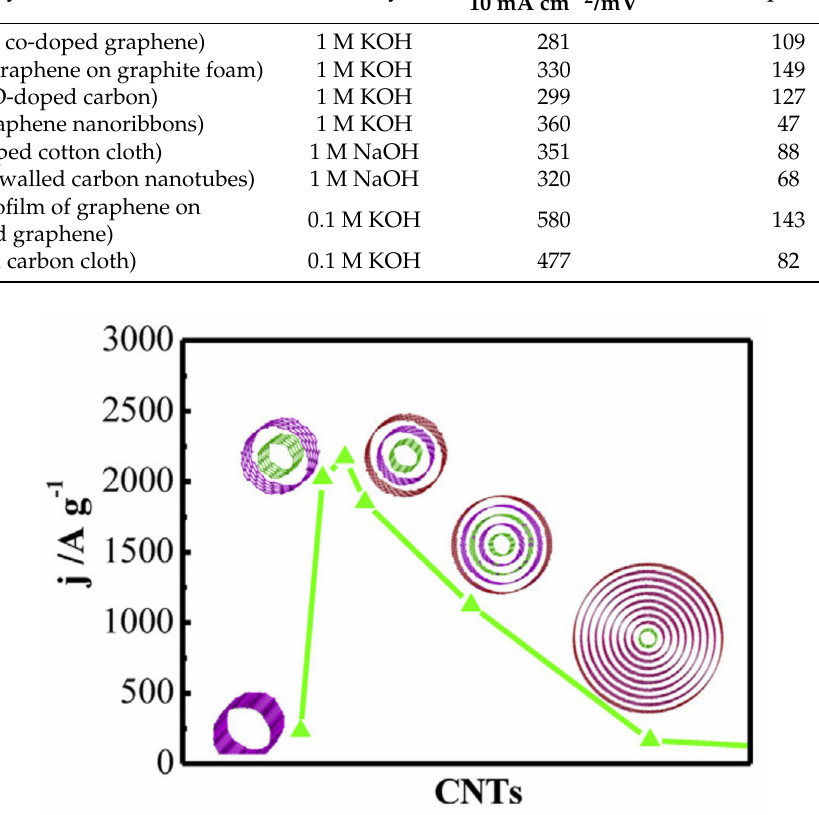
Figure 9. A plot of the activity of CNTs for the OER in 1 M KOH solutions as a function of the number of walls. The mass-specific activity was measured at 1.8 V (vs. RHE) at a scan rate of 1 mV s − 1 and rotating rate of 2000 rpm with CNTs loading of 0.025 mg cm − 2 . Reprinted from Applied